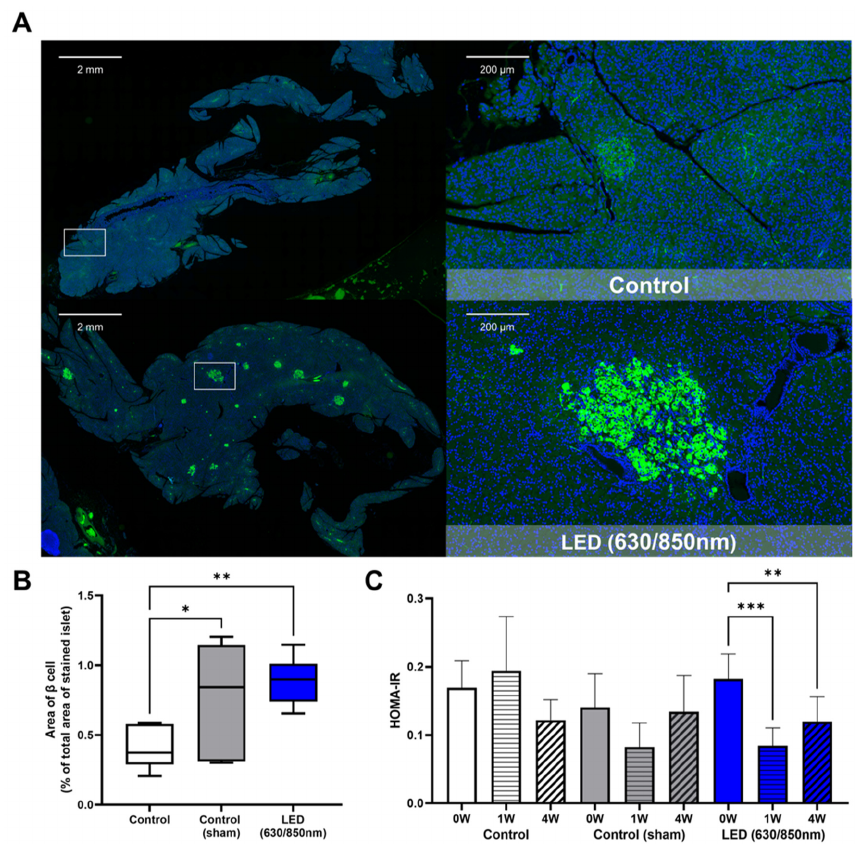
Figure 3. ( A ) Representative pancreatic islets (selected islet in the white box) stained with immunohistochemistry for insulin ( β cell) from the control and duodenal dual-wavelength (630/850 nm) PBM (low magnification: 0.4 × , high magnification: 5 × ). ( B ) Comparison of quantitative percentage of the total area of stained pancreatic islets in control, sham control, and D-PBM at 4 weeks after the experiment. ( C ) HOMA-IR of the three groups group at 0, 1, and 4 weeks. Values are expressed as mean ± SEM of five rats in the control and sham control and six rats in the D-PBM group. * p < 0.05; Cells 2022 , 11 , 3490 ** p < 0.01; *** p < 0.005.